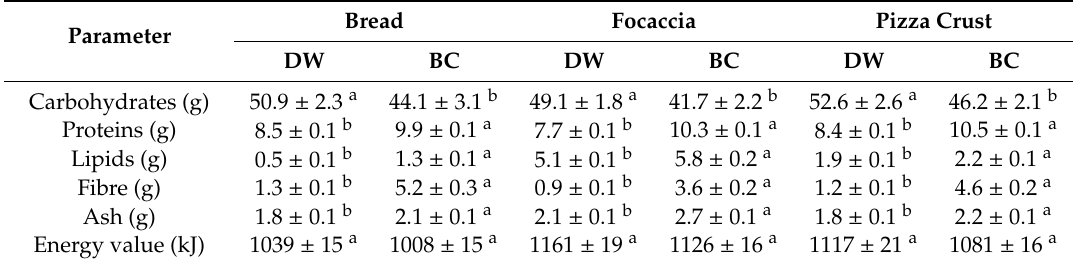
Table 5. Nutritional features (values per 100 g, expressed on fresh weight basis) of conventional durum wheat bread, focaccia, and pizza crust and of their black chickpea-enriched versions. DW =